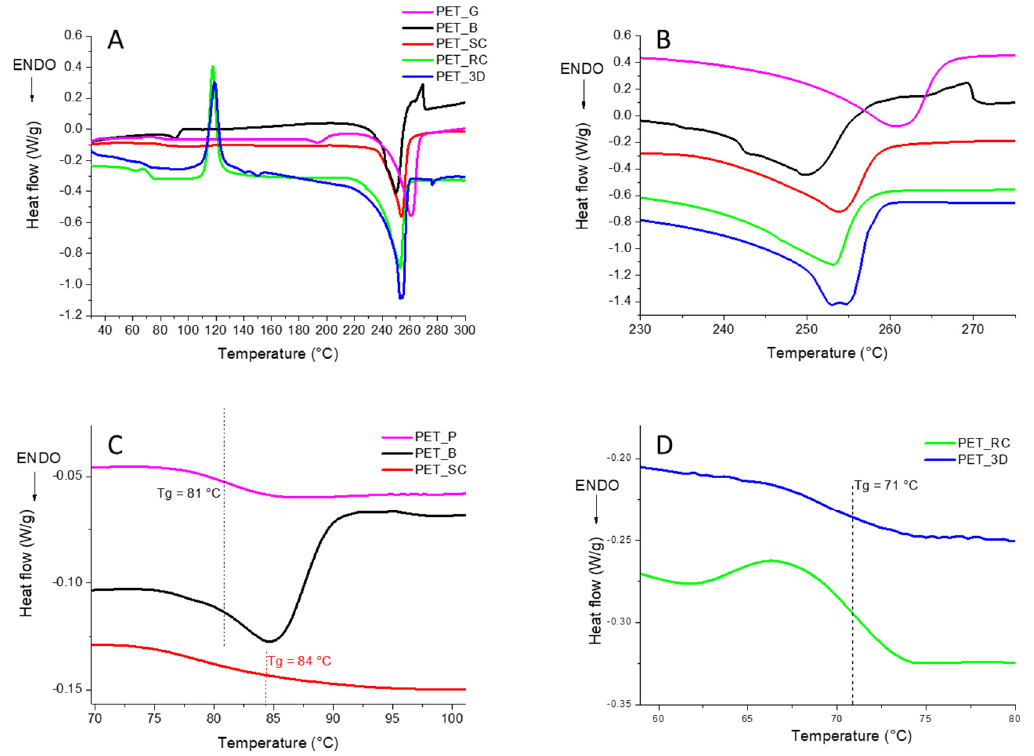
Figure 3. DSC analysis of PET samples ( A ). Temperature interval of melting ( B ) and glass transition ( C – D ).